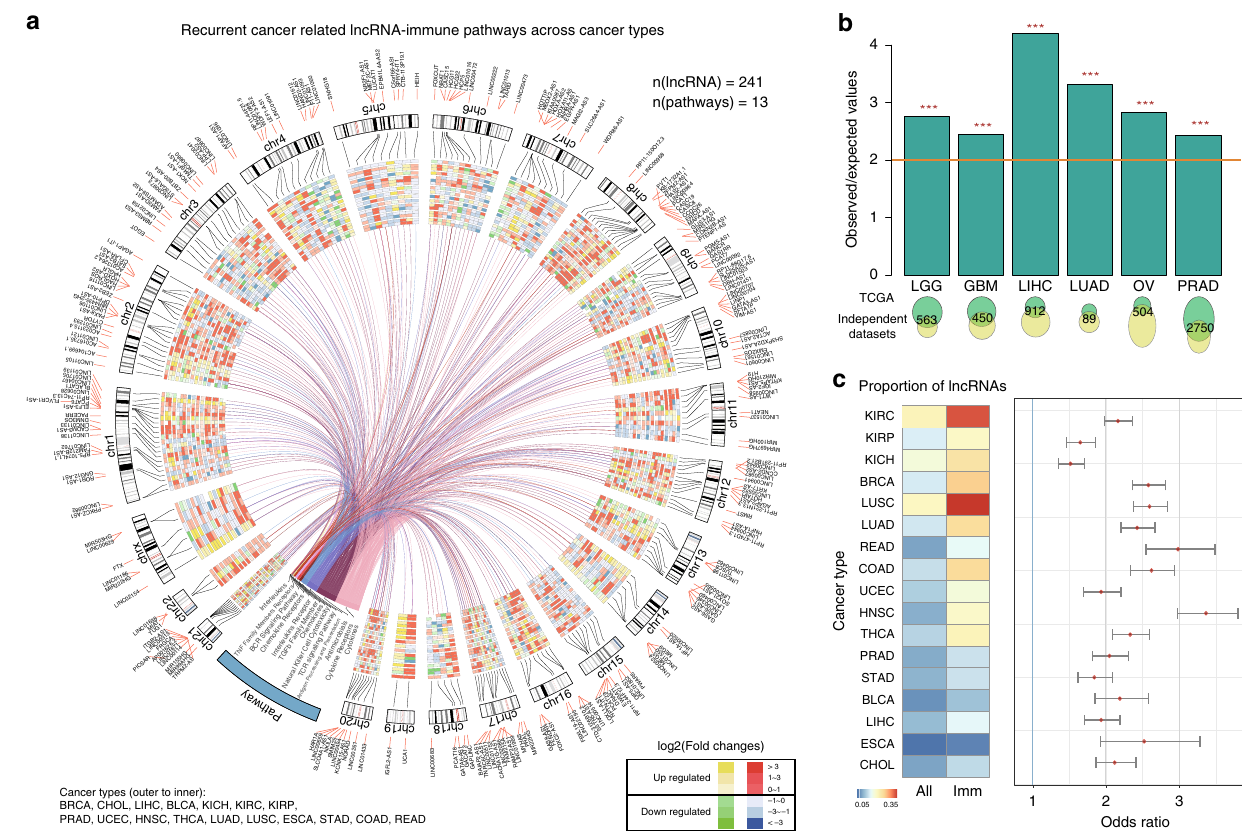
Fig. 2 Validation of immune-related lncRNAs. a . Circos plot showing the 500 top-ranked lncRNA – pathway pairs across cancer types. The inner heat map shows the differential expression of lncRNAs across cancer types. Red and yellow colors represent upregulation; blue and green colors represent downregulation. b The overlap of immune – lncRNA pathways in independent datasets of the same cancer type. The top bar plots show the observed/ expected values of the hypergeometric test. The bottom Venn plots show the number of overlapping lncRNA – pathway pairs. ***all P < 2.2E-16, two-sided hypergeometric tests. c The left heat map shows the proportion of differentially expressed lncRNAs of all lncRNAs and of immune-related lncRNAs. The right panel shows the odds ratios in each cancer type. All P < 0.01, two-sided Fisher ’ s exact tests. The error bars were 95% con fi dence levels of odds ratios. Source data are provided as a Source Data fi